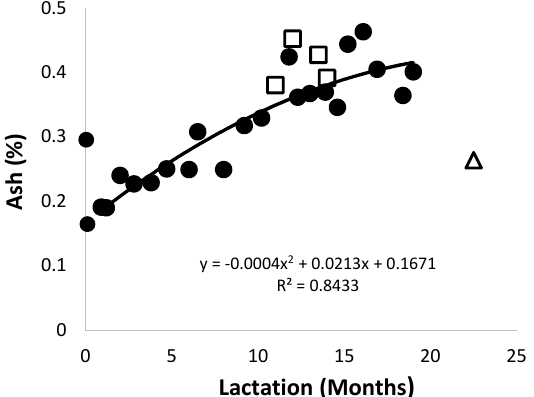
Figure 1. Changes of the ash content in milk of three African elephants during lactation (Shorty ( ● ), Mussina ( □ ), and Shan ( Δ )). The trend line of combined data of all animals was y = 0.0122x + 0.1671 and R 2 = 0.8297.